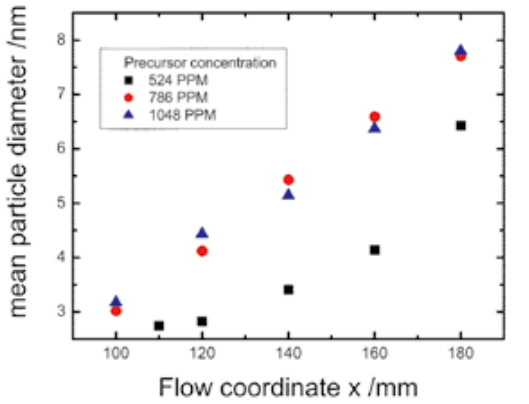
Fig.2 Particle growth of tin oxide nanoparticles downstream of the flame reactor as measured with a